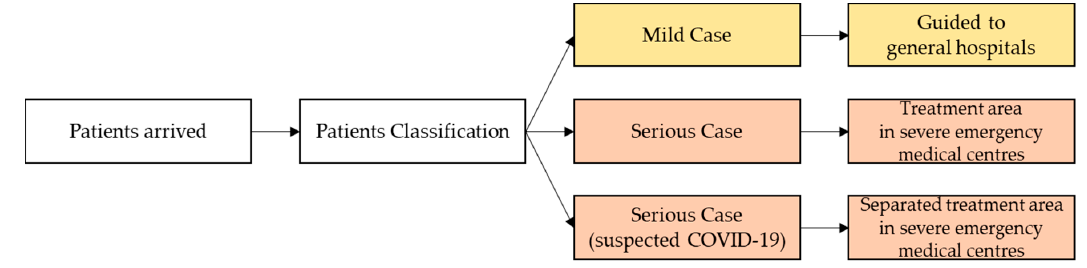
Figure 8. Severe emergency medical centre system.